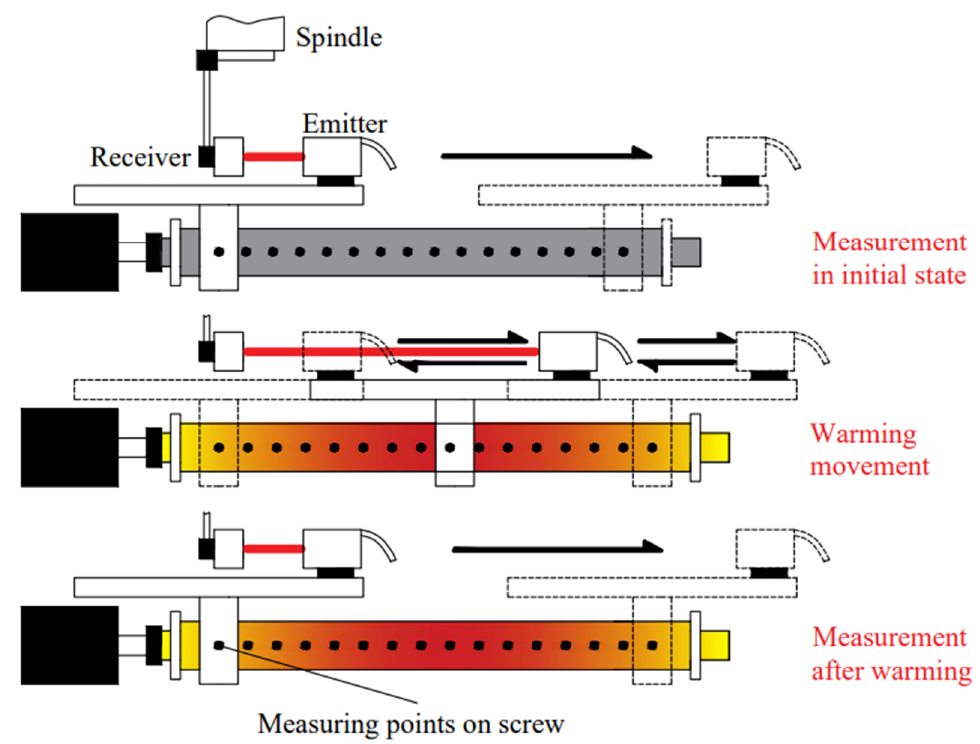
Figure 8. XM – 60 measurement process (x-axis as an example).